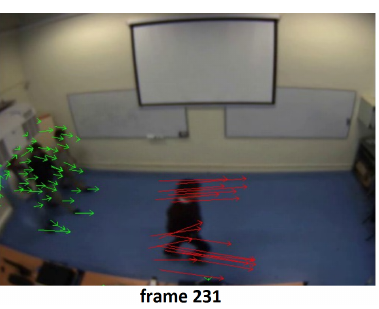
Figure 4. (a). Corners detection (b). Corners tracking (c). Clustering Figure 6. Event detection: video with several moving persons (Fig. 7.(c)), motions close to this model are inhibited while only di ff erent motion (in other spatial locations) is highlighted. The event localization using scene occupation model follows three principal steps: